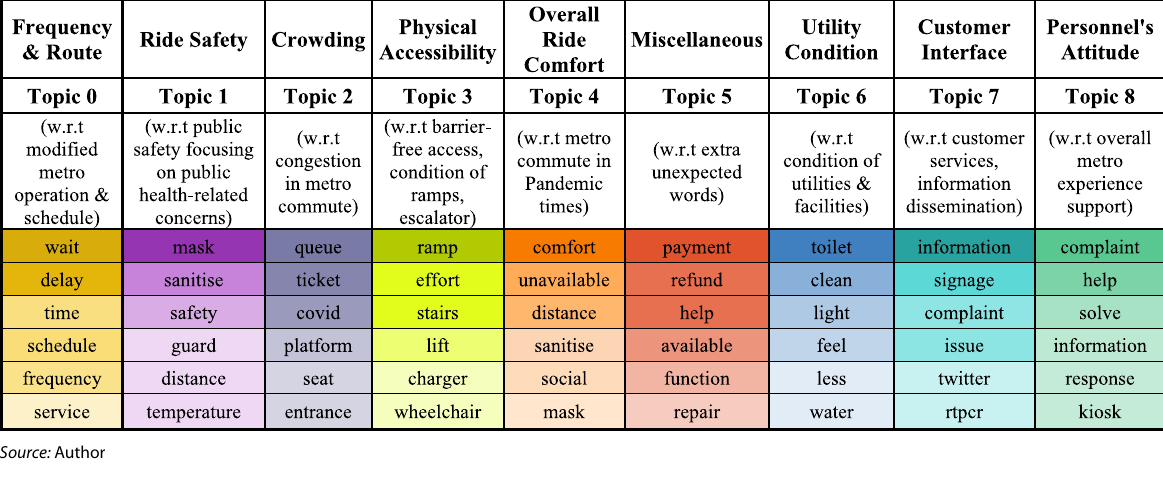
Table 1 Predicted topics with associated words